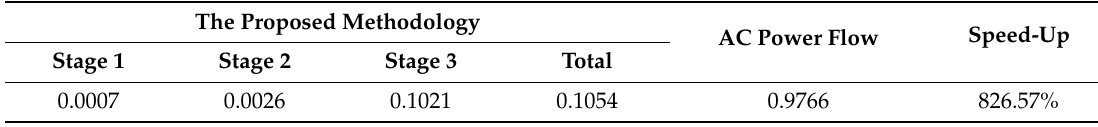
Table 2. CPU time required for the example (seconds).